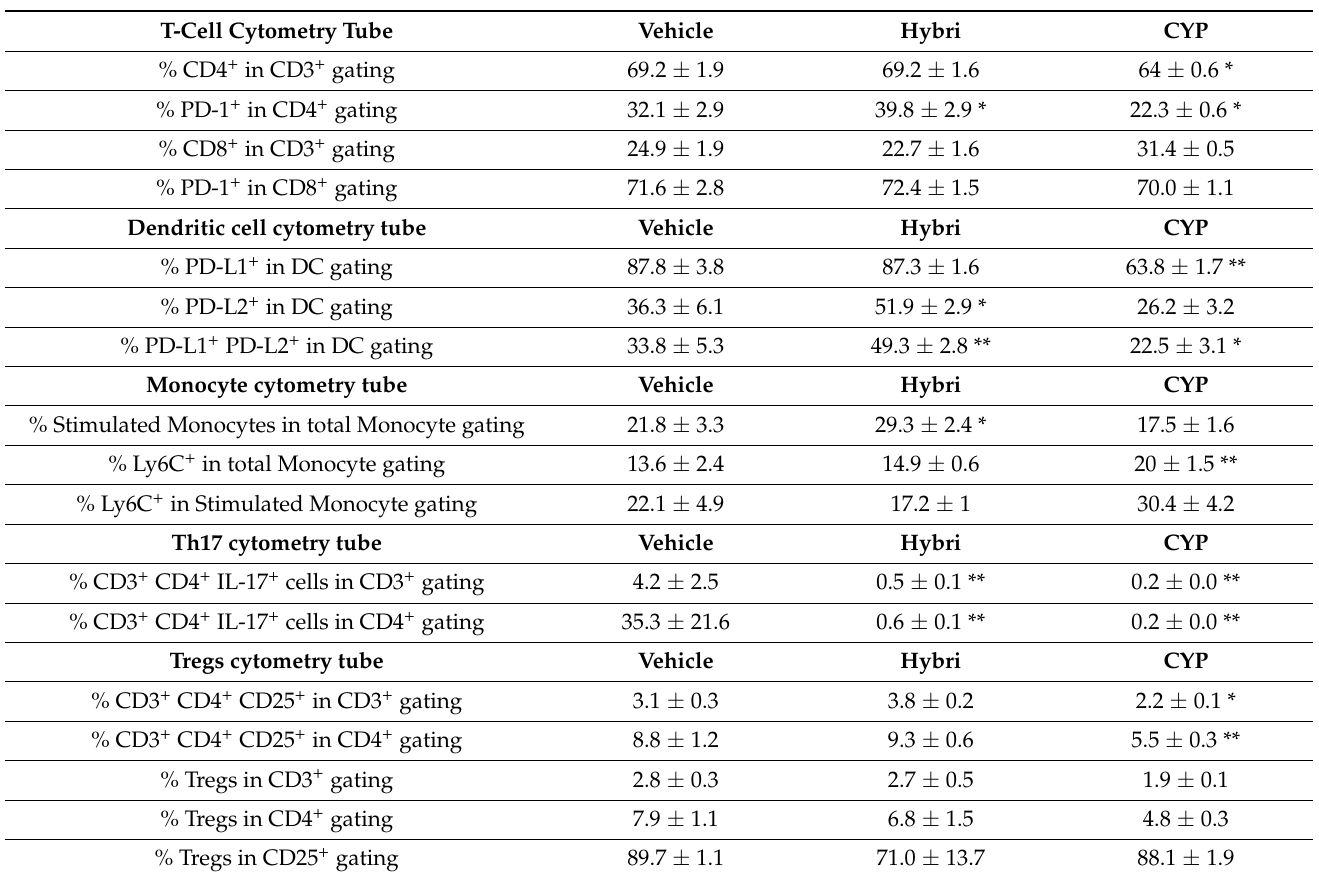
Table 1. Peripheral blood cell subsets at the end of the study, at 36 weeks of age in NZBWF1 mouse model analyzed using flow cytometry technique. Results are expressed as percentages ± S.E.M. * p < 0.05 versus vehicle; ** p < 0.01 versus